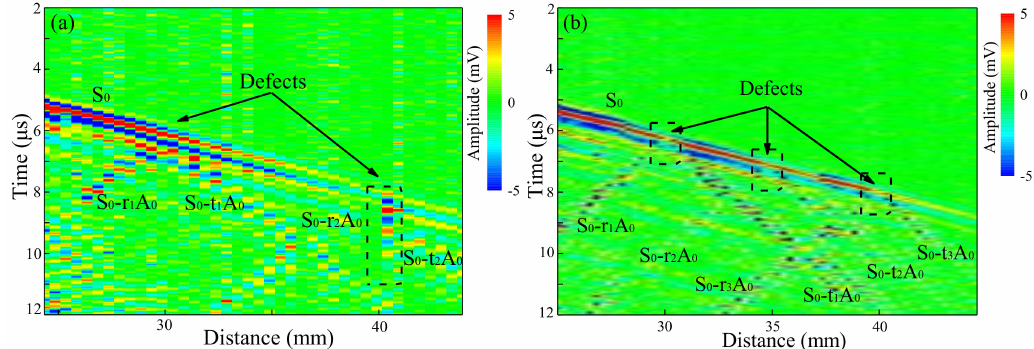
Figure 9. B-scan images of underwater plate with multiple defects: ( a ) two notches; ( b ) three